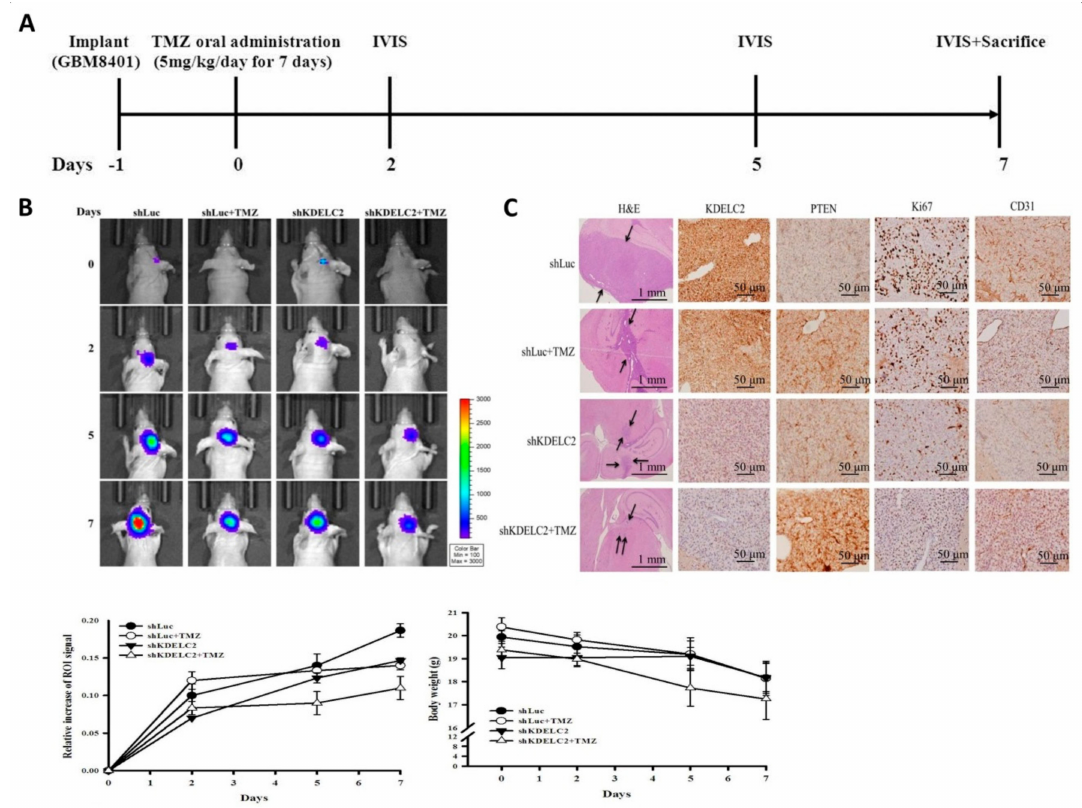
Figure 11. E ff ects of KDELC2 expression in orthotopic human GBM orthotropic xenograft mouse models. ( A ) The schedule of tumor implantation, in vivo imaging system (IVIS) measurement, and sacrifice. ( B ) IVIS assay showed that the shKDELC2 + TMZ group of mice had the least proliferative activity. ( C ) H&E and IHC stains of mice brain tumors revealed a smaller tumor area and lower Ki67, VEGFA, and CD31 expression levels in the shKDELC2 + TMZ group of mice (arrow indicates tumor-distributed